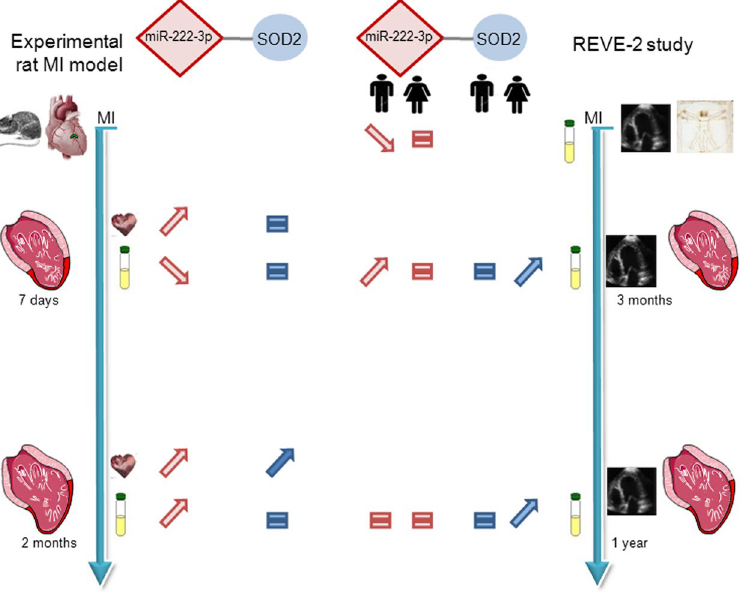
Figure 4. Summary of expression of miR-222-3p and one of its targets SOD2. miR-222-3p and SOD2 were quantified in LV and plasma of experimental model of MI rat at 7 days (n = 9) and 2 months (n = 9) after MI (n = 18) or sham (n = 18) surgery. The circulating levels of miR-222-3p and SOD2 were quantified in plasma of REVE-2 patients (n = 224) respectively at baseline, 3 months, 1 year post-MI and 3 months and 1 year post-MI. Analysis were performed by separating women (n = 46, 24 no LVR and 20 high LVR) and men (n = 200, 114 with no LVR and 66 with